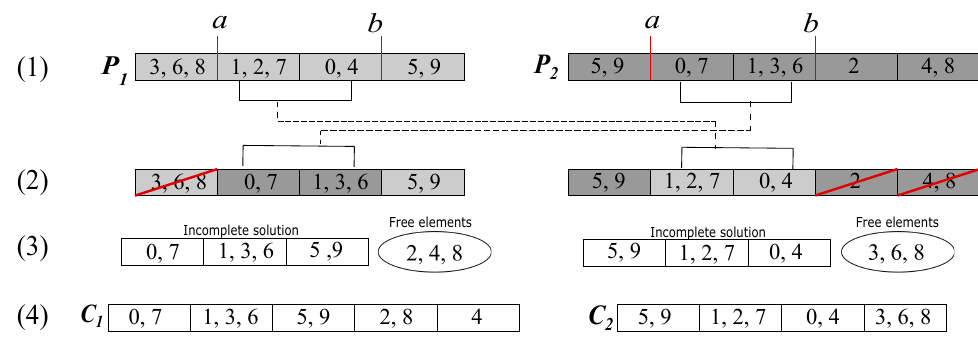
Figure 2. Two-point crossover operator.